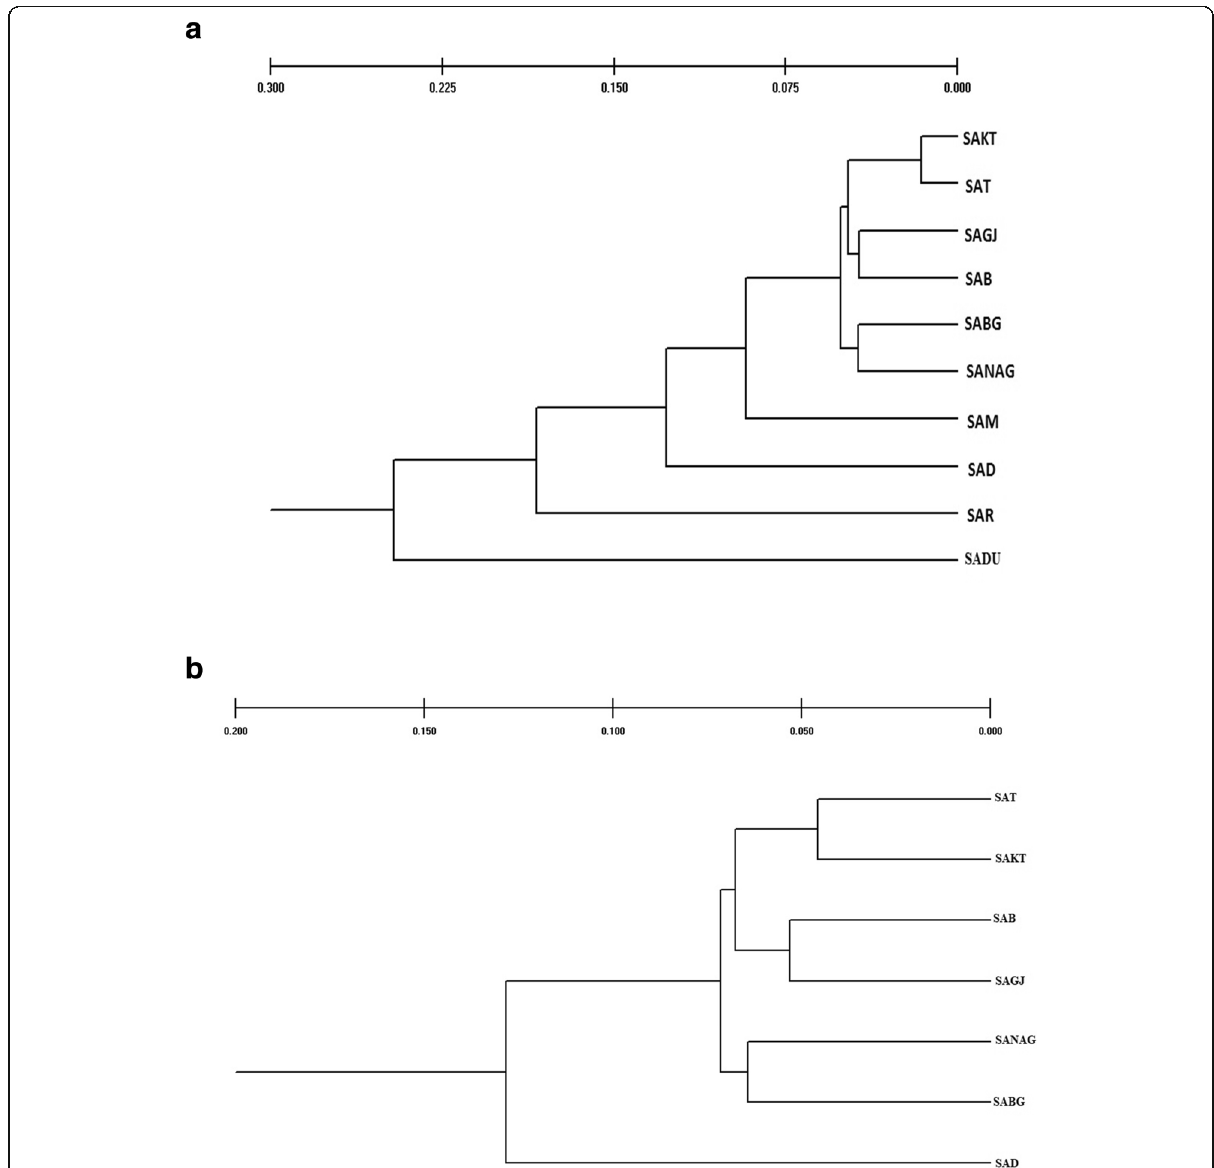
Fig. 2 UPGMA dendrograms based on Nei ’ s genetic distances showing clustering patterns of a ten S. asoca accessions and b seven wild S. asoca accessions